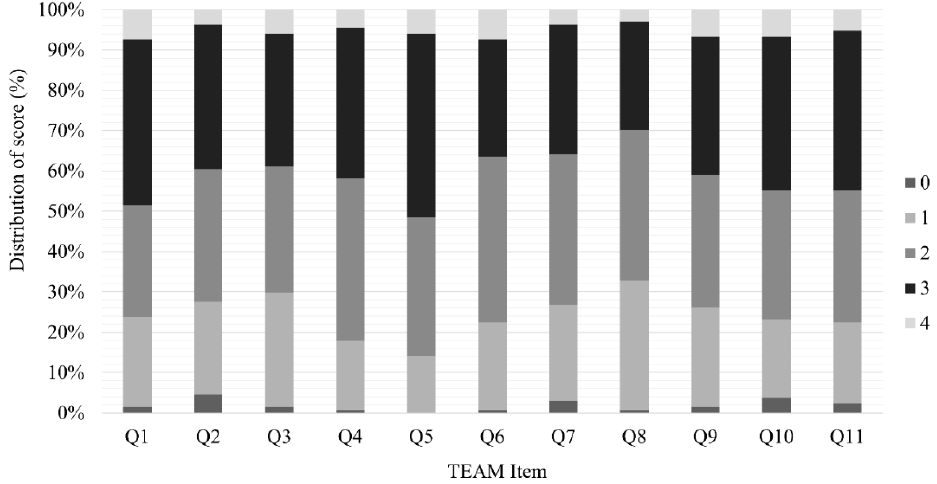
Figure 2. Distribution of the results of the TEAM. Abbreviation: TEAM, Team Emergency Assessment Measure.